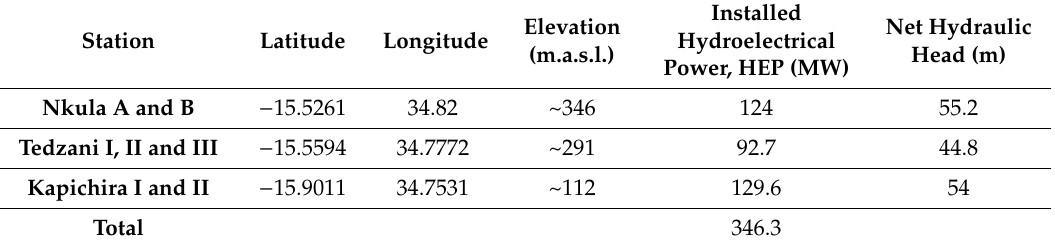
Table 1. The seven hydropower stations on the Shire River in Malawi in 2020 (From http://www.egenco.mw/page.php?slug=power-stations (official site of Electricity Generating